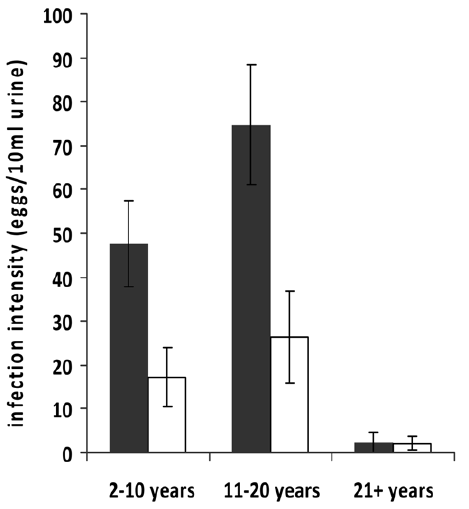
Figure 1. Distribution of schistosome infection intensity with age in the study villages: Mean infection intensity is higher in Magaya Village, high schistosome infection area (black) compared to Chitate Village, low schistosome infection area (white). Bars represent standard error of the mean.